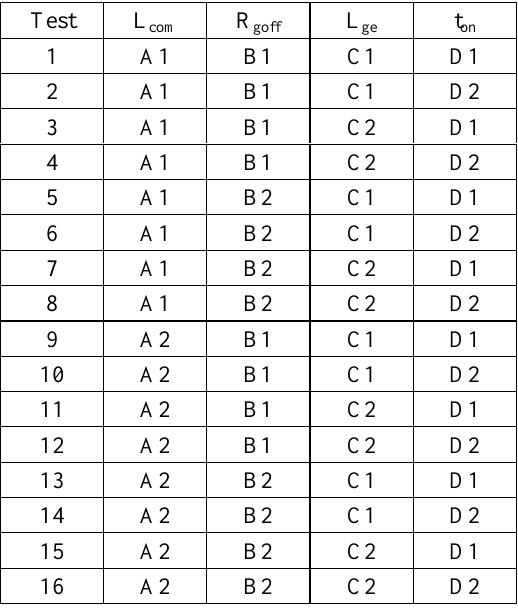
Table 3: Full factorial design for 4 factors with